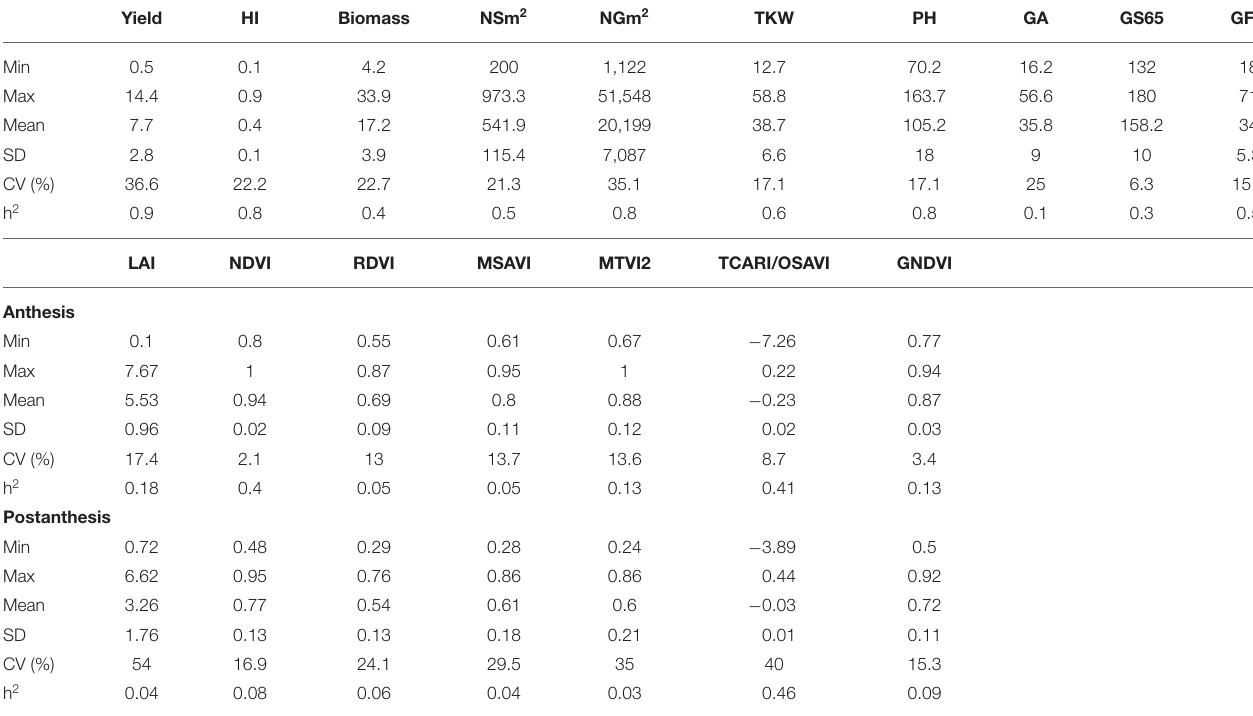
TABLE 2 | Summary statistics of the agronomic traits, leaf area index (LAI), and VIs. Yield